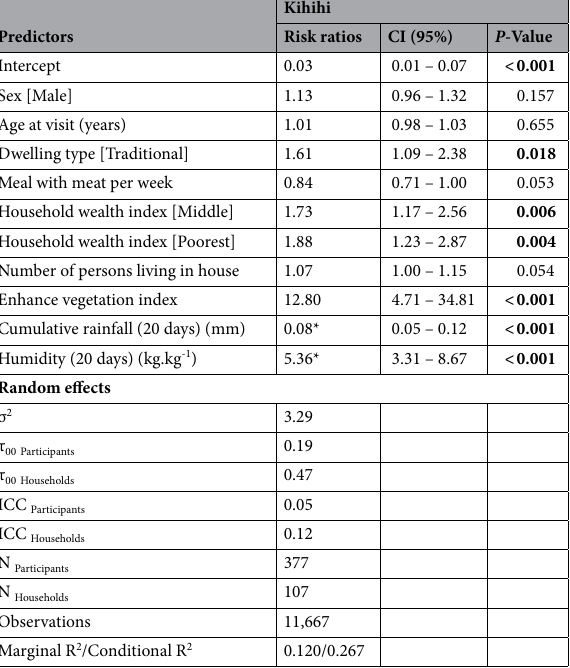
Table 4. Summary of GLMM model for Kihihi. Significant values are in bold. *Risk ratio of malaria when the meteorological linear variable changes from its minimum to its maximum